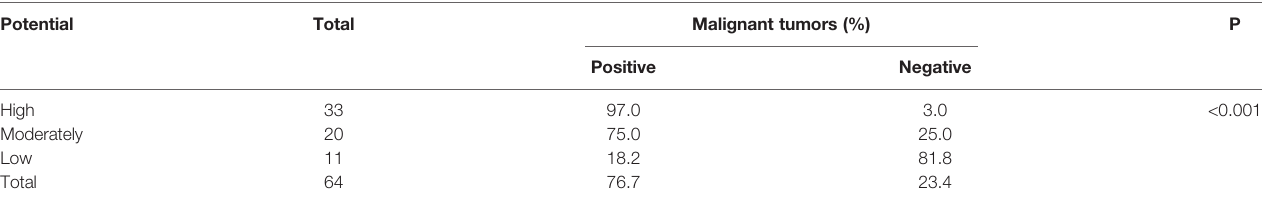
TABLE 4 | Rate of malignant tumors in patients with ureteral occupying with high, moderate, and low potential, as indicated by SUVmax and lesion size (n=64). Potential